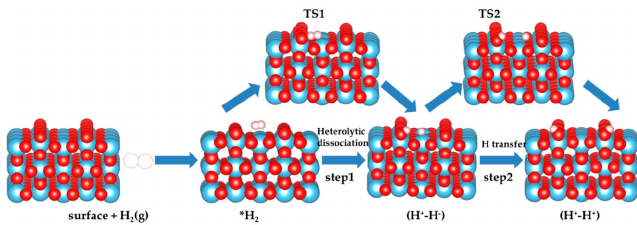
Figure 2. Schematic two-step mechanism considered in the present work. The heterolytic dissociation pathway of H 2 over TiO 2 surface (step 1) and sequential H transfer from Ti to near O (step 2). Ti, O, and H atoms are depicted by blue, red, and white spheres, respectively.